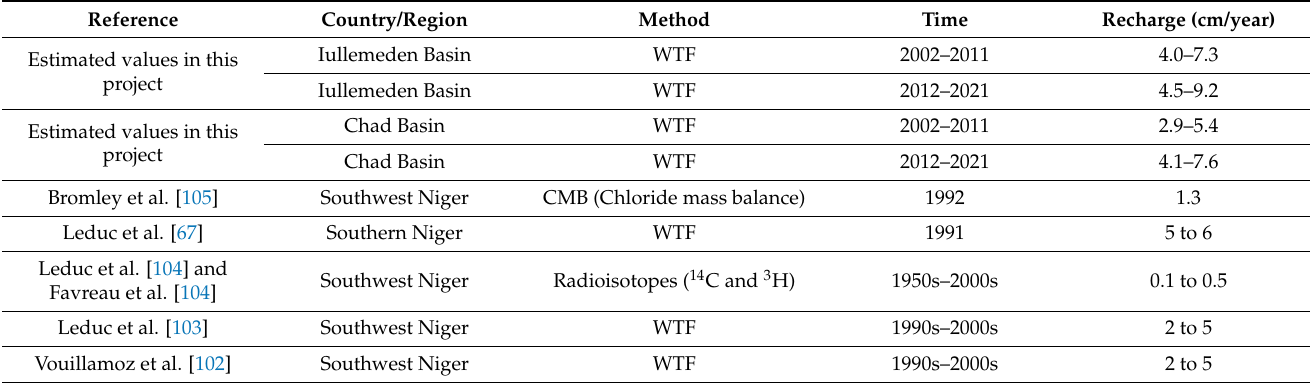
Table 1. Average recharge value (from 2002 to 2020) compared with results from prior studies.